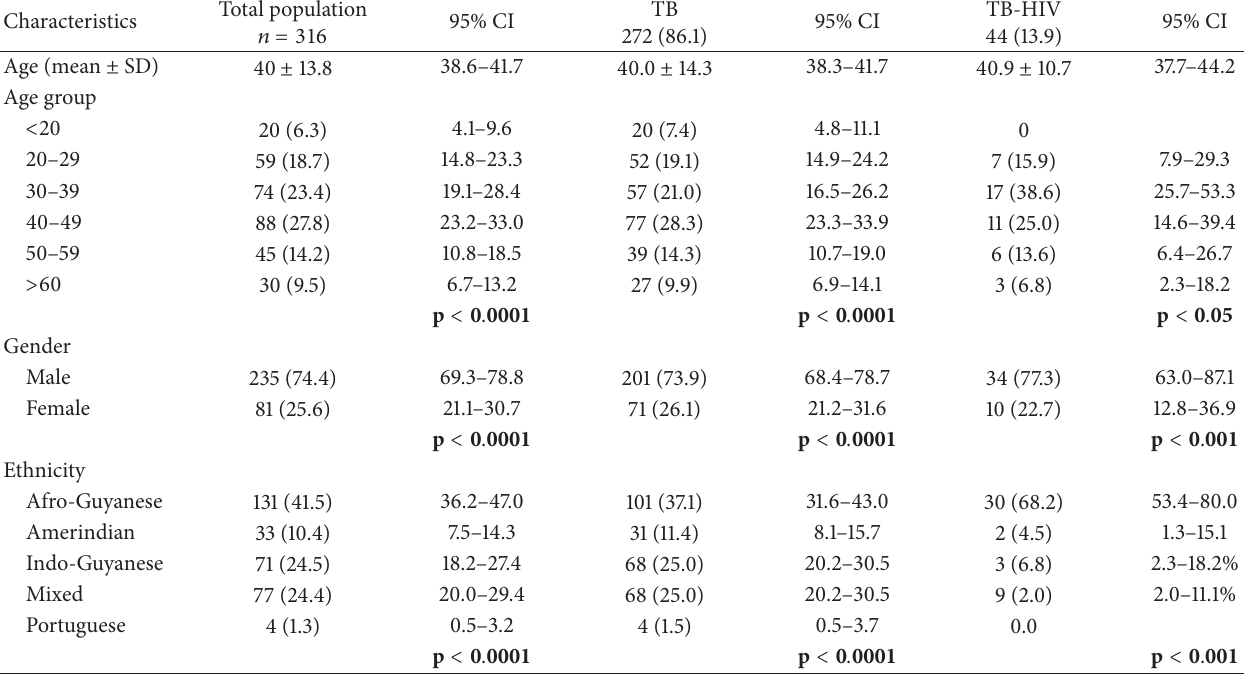
Table 1: Characteristics of study population in the Georgetown Chest Clinic, Guyana.